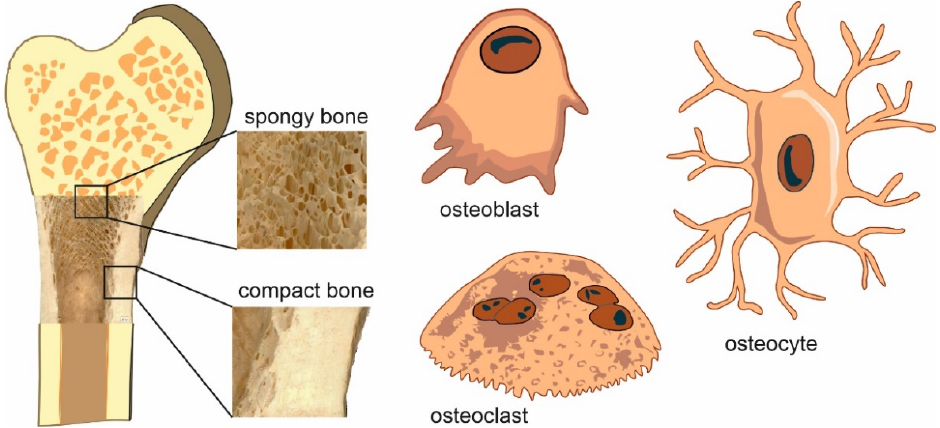
Figure 2. The microscopic structure of the bone and types of bone cells. The cells are not of comparable size.